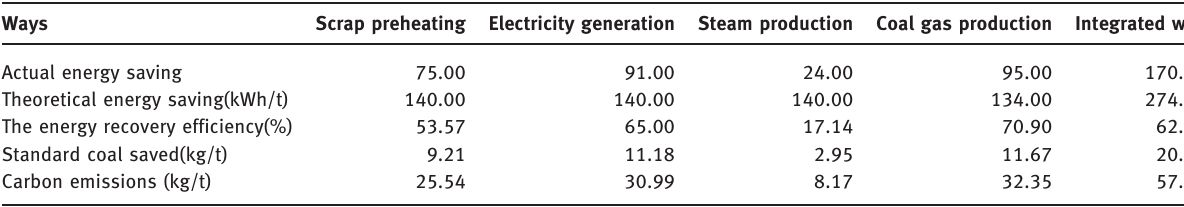
Table 2: The effect of energy saving and emission reduction for EAF gas waste heat